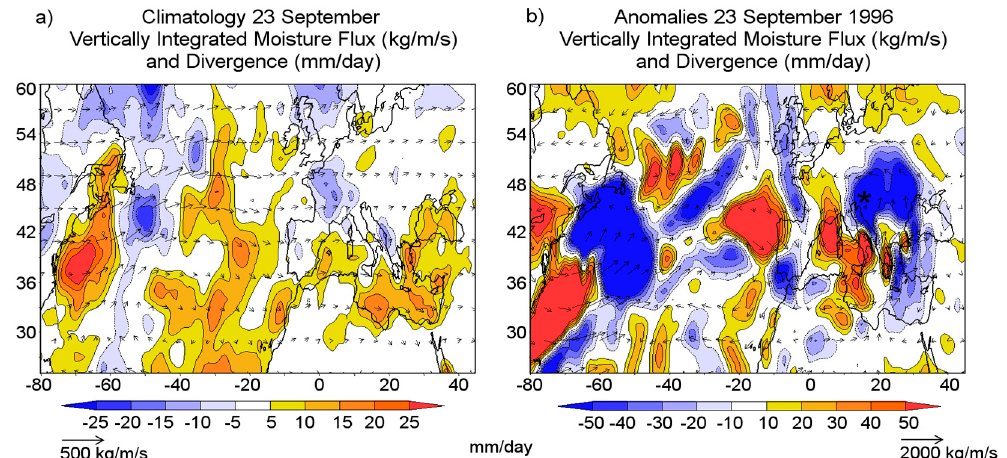
Figure 5. Left hand ( a ): Climatological daily mean Vertically Integrated Moisture Flux (VIMF) values for 23 September during the period 1981–2015. Right hand ( b ): Daily mean anomalies of VIMF values for the day 23 September 1996. Vectors measured in kg m − 1 s − 1 and respective divergence shaded and measured in mm day − 1 . The black asterisk marks the central position of the low. Data from ERA-Interim at 1° degree in latitude and longitude.